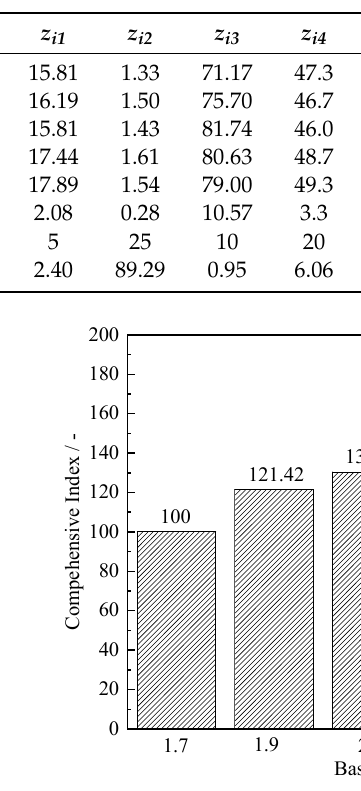
Figure 12. E ff ect of basicity on the comprehensive index of HCVTM Figure 12. Effect of basicity on the comprehensive index of HCVTM sinters.